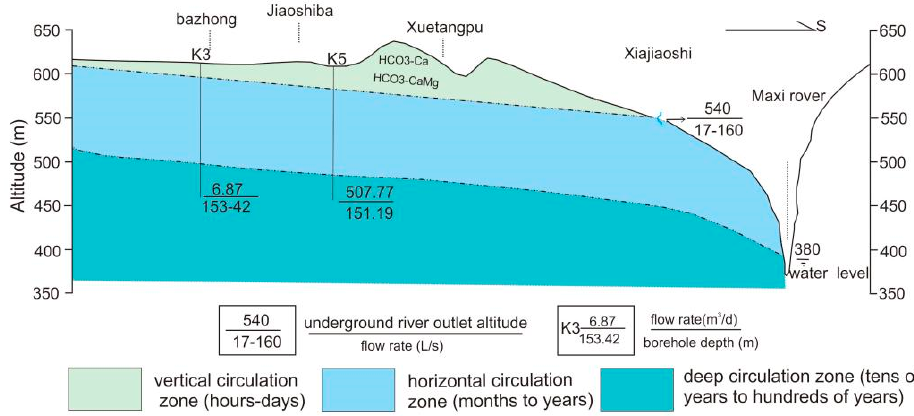
Figure 6. Hydrogeological cross ‐ section and circulation depth of karst aquifers in the JSB areas. The high 3 H (6.5–8.6 TU) and 14 C content of shallow groundwater (95.4–98.6 pmc) indicate that